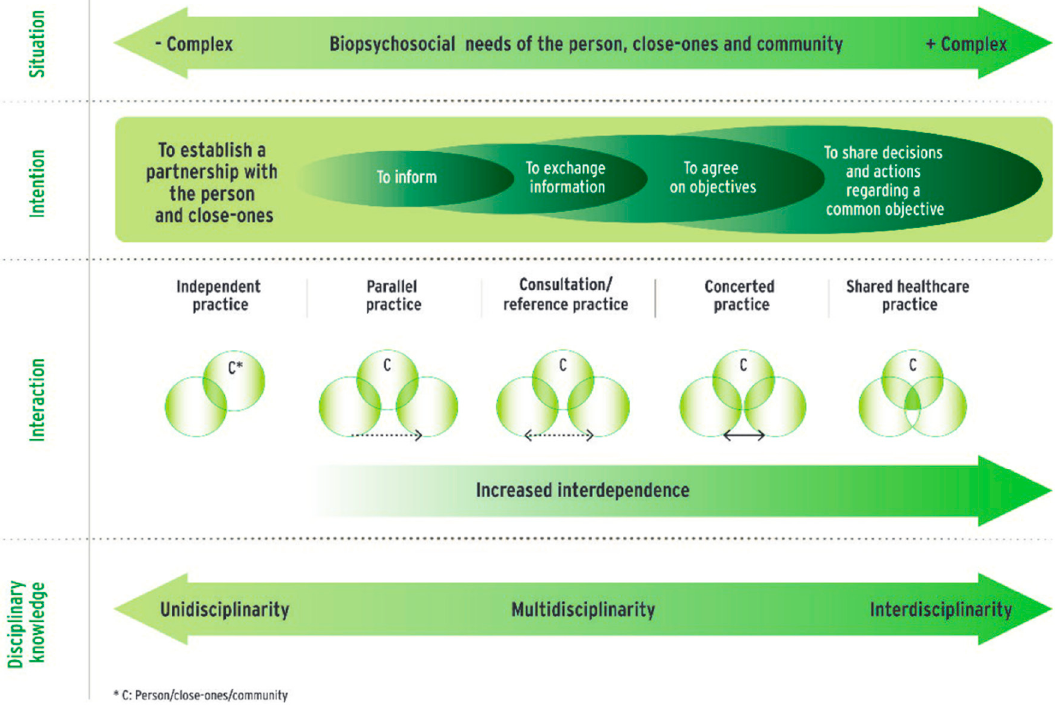
Figure 4. Continuum of Interprofessional Collaborative Practice in Health and Social Care [46]. + and - Complex indicators define the complexity of the needs of the person/close-ones/community and the biopsychosocial context in which these needs are to be met.